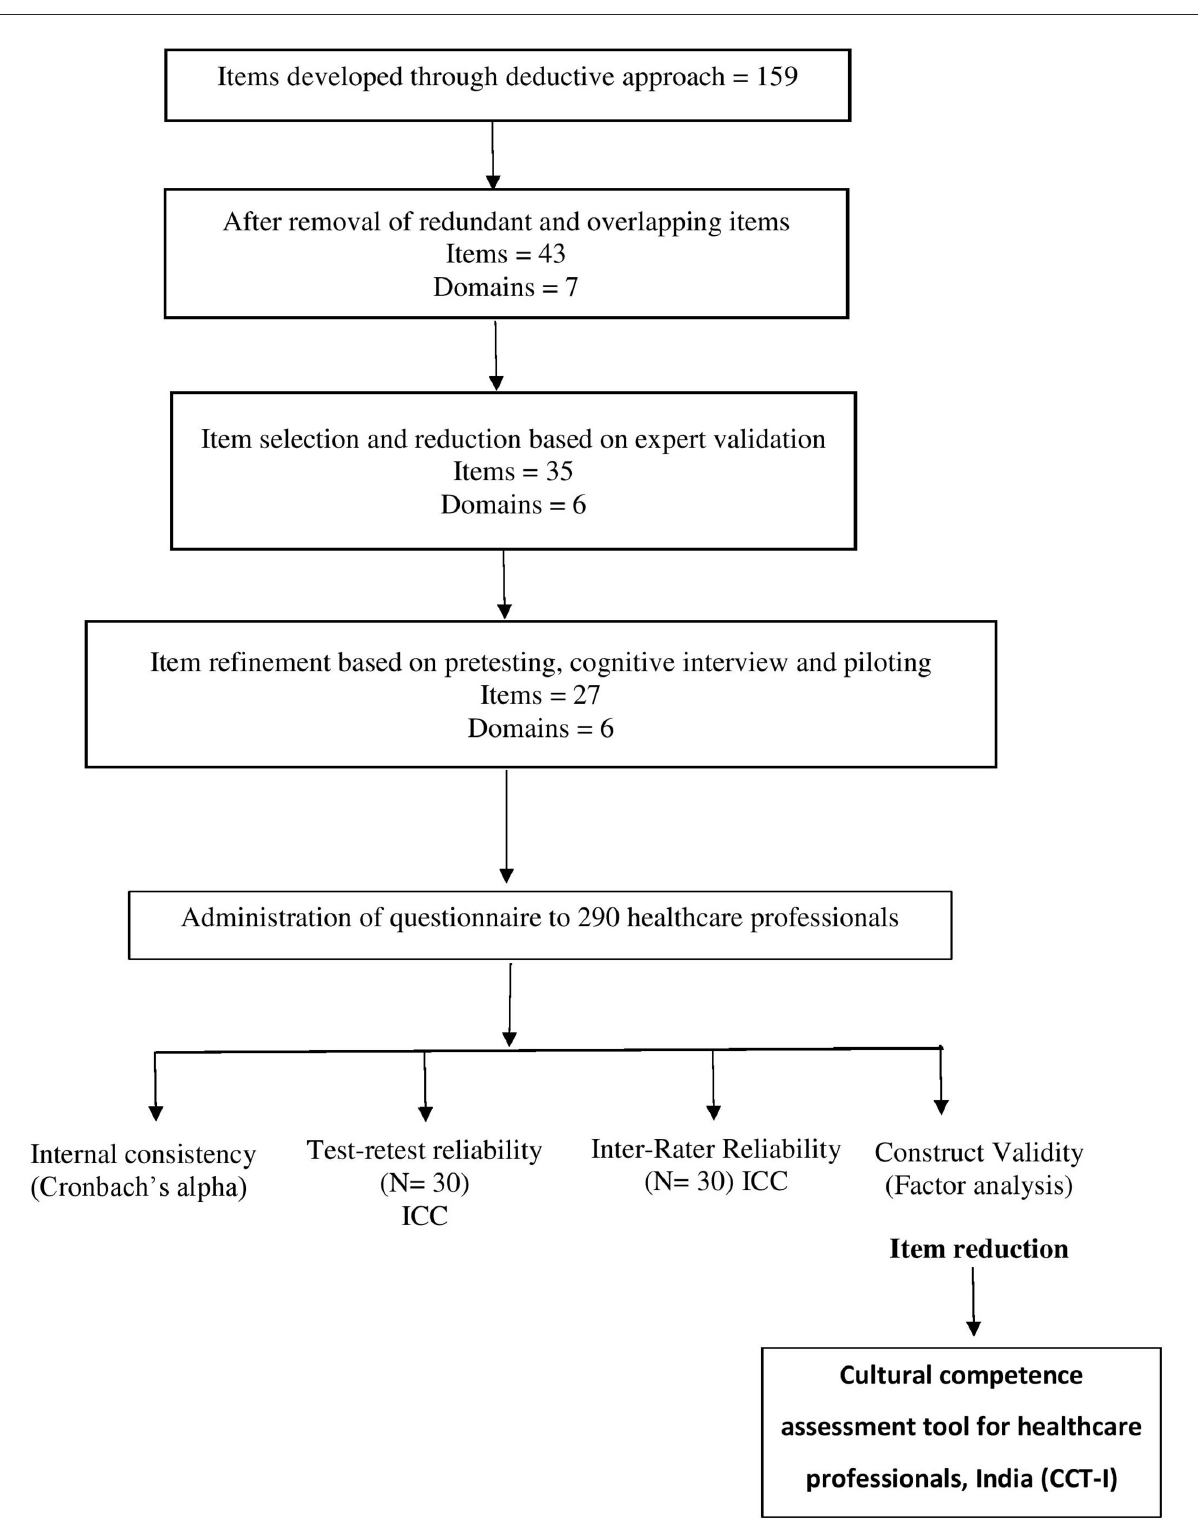
FIGURE2 Flow chart showing the steps in the development of the new